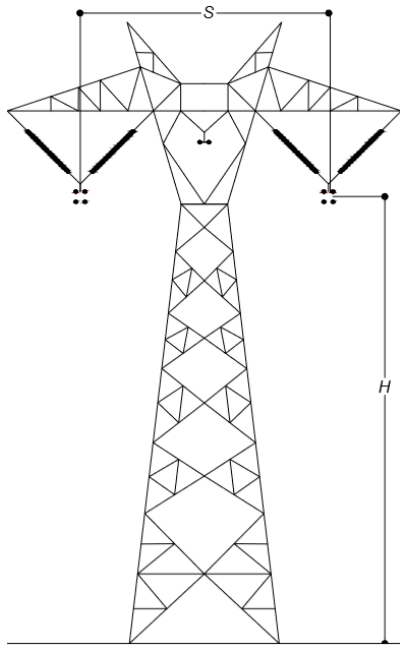
Figure 3. Tower geometry of a bipolar HVDC transmission line. Table 2. Data of the HVDC lines considered in the simulations.